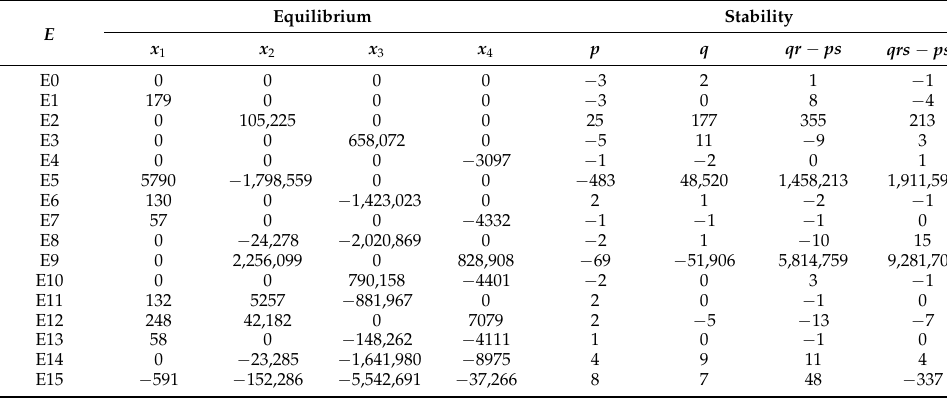
Table 8. Estimated equilibrium and eigenvalues in